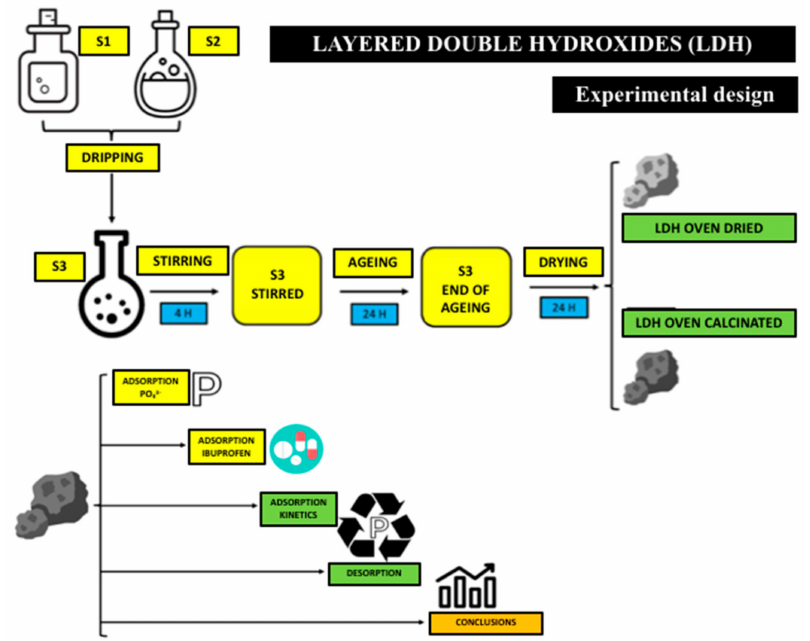
Figure 1. Flowchart illustrating the overall approach used in this